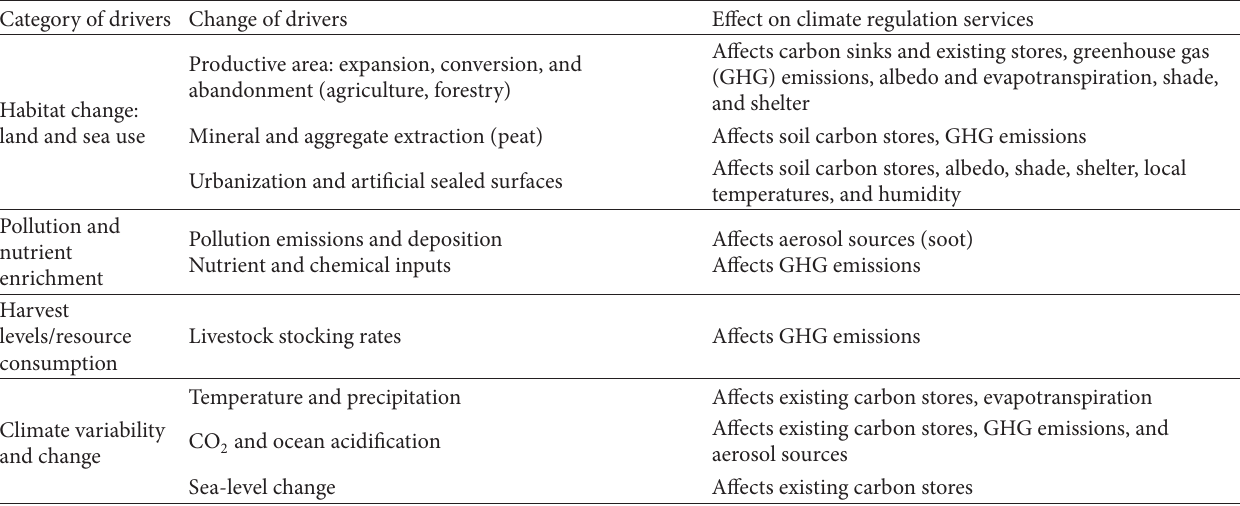
Table 1: Direct drivers of changes in climate regulation and their corresponding effects, adapted from